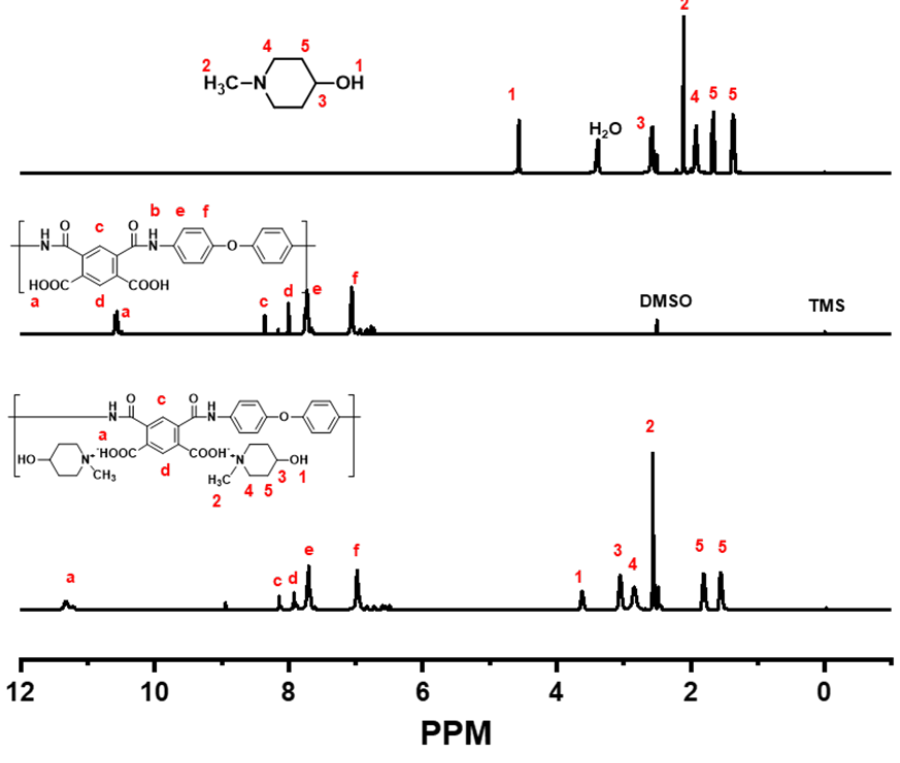
Figure 4. 1 H NMR spectra of HMP, PAA, and PAS.